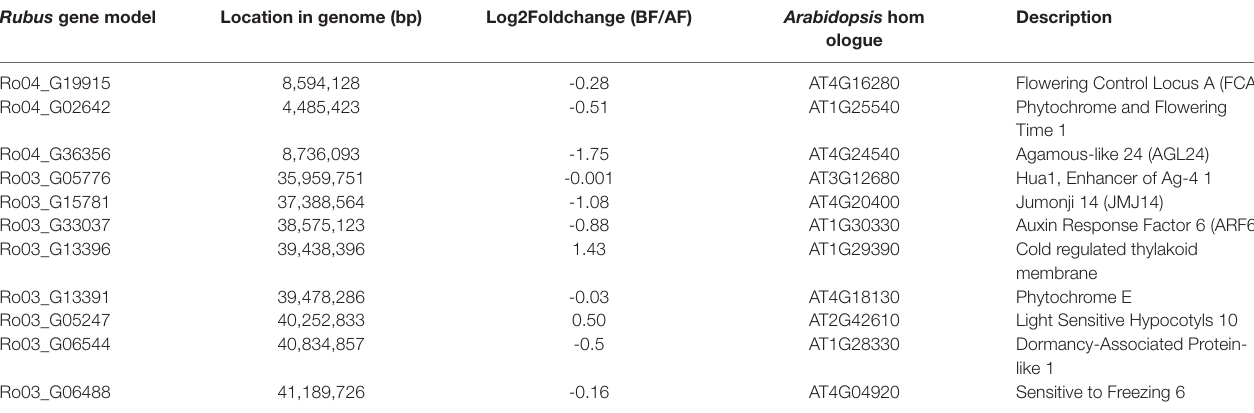
TABLE 4 | Differentially expressed candidate genes that underlie RiAF3 and RiAF4 loci. Rubus gene model